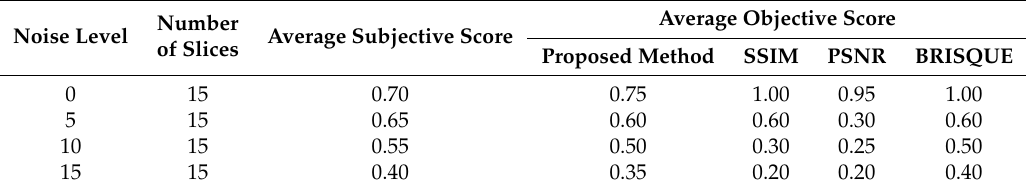
Figure 10. Comparative performance evaluation of the proposed method with SSIM, PSNR and BRISQUE quality metrics using ( a ) 15 slices in a T2 MRI volume data, ( b ) 15 slices in a T1 MRI volume data, ( c ) 15 slices in a breast MRI volume data and ( d ) 10 slices in a short axis cardiac MRI volume data. Table 1. Comparative Performance Evaluation of the Proposed Method with SSIM, PSNR and BRISQUE Quality Metrics using T2 MRI Sequence.